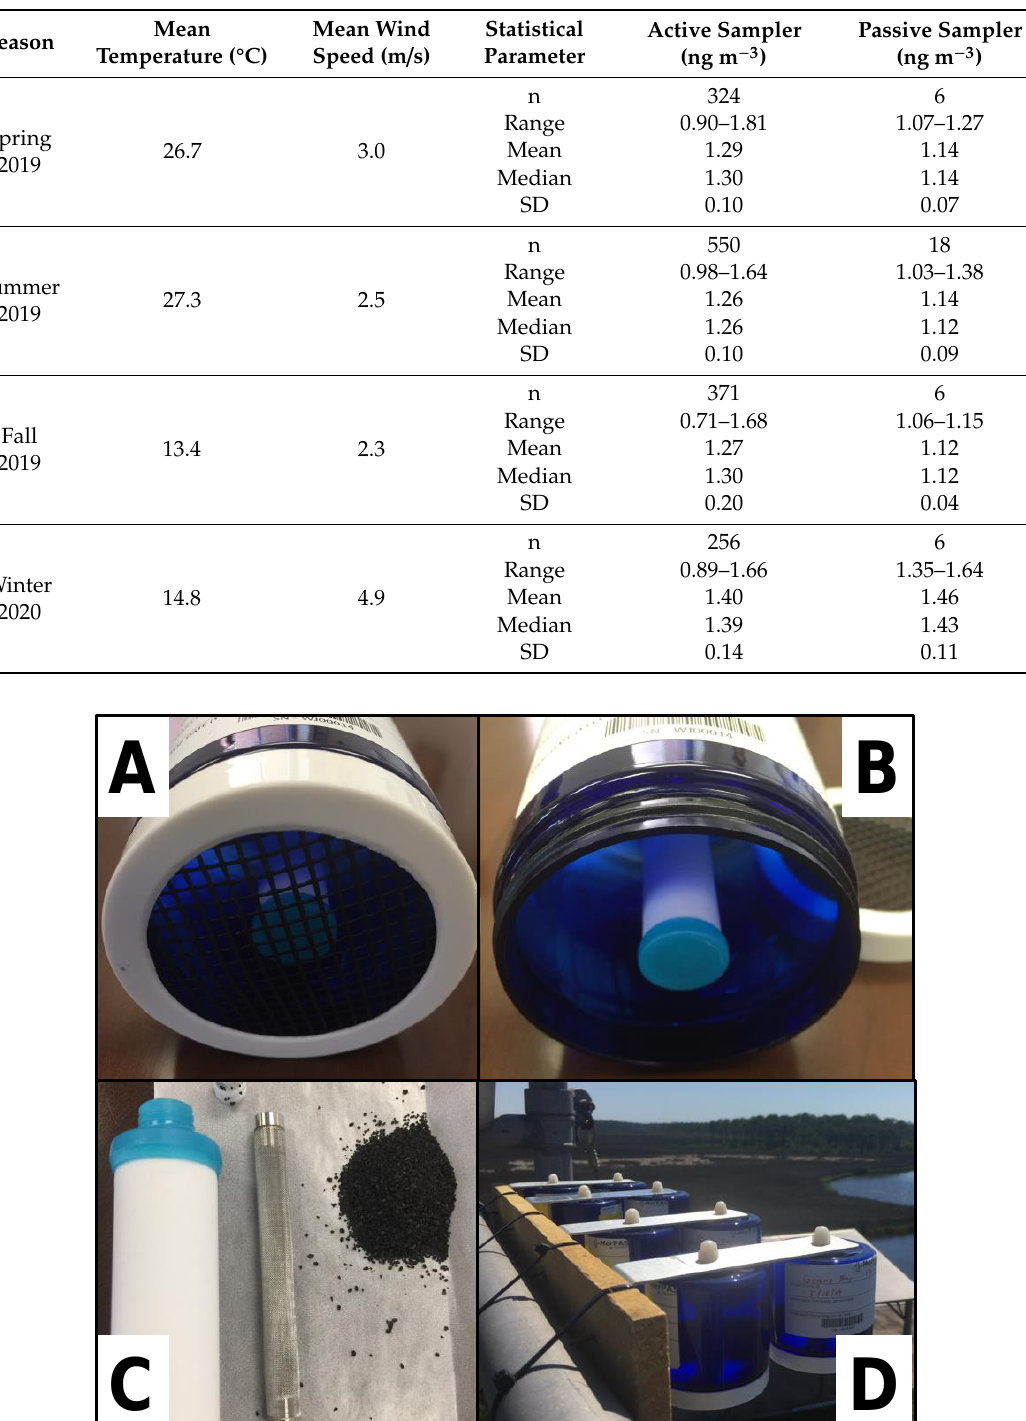
Table A3. Summary statistics for GEM concentrations at Grand Bay NERR by active and passive sampling along with meteorological data used to obtain the adjusted sampling rate for each PAS.